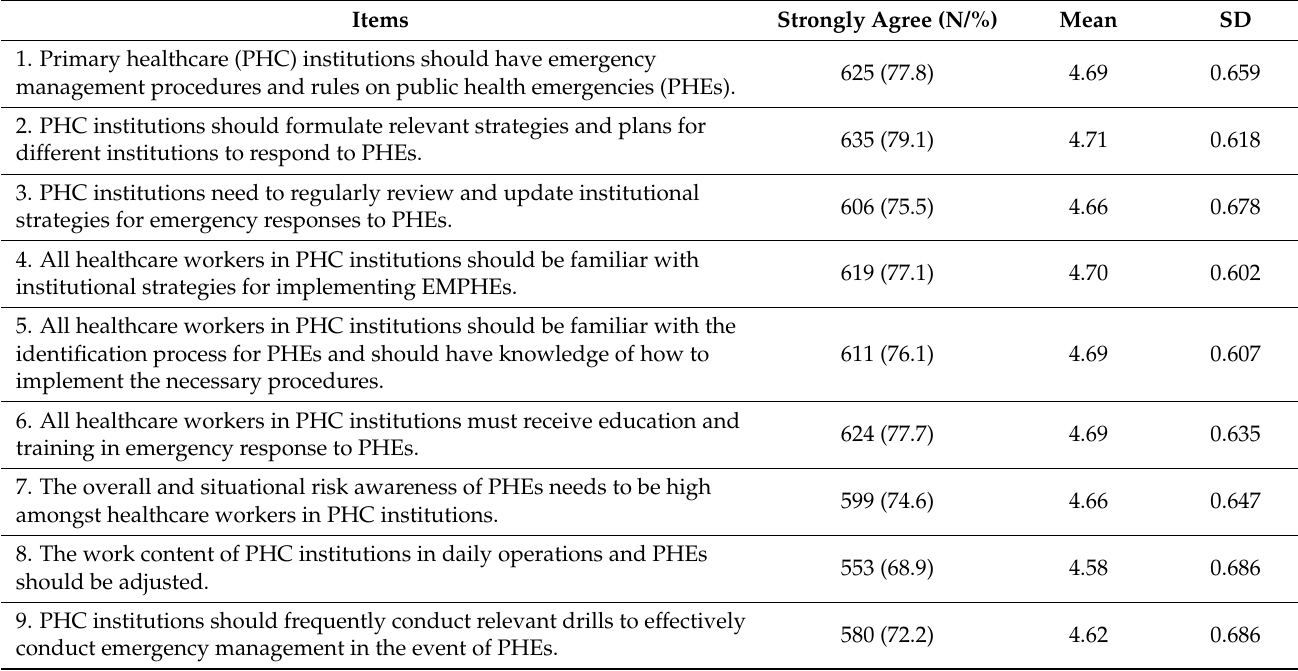
Table 2. Attitudes of healthcare workers at PHC institutions (toward